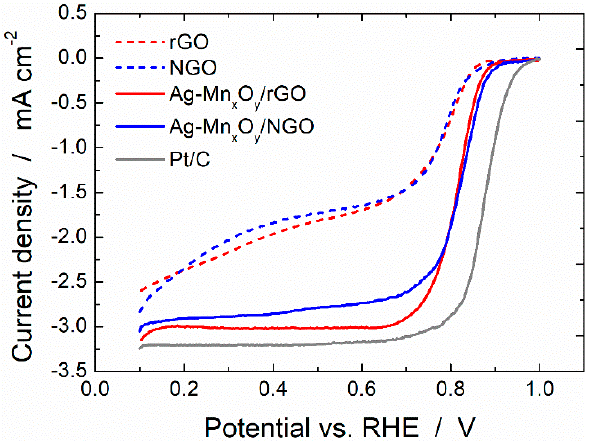
Figure 5. Potentiodynamic ORR curves of Ag-Mn x O y /rGO and Ag-Mn x O y /NGO catalysts, support materials, and comm. Pt/C in O 2 saturated 1 M KOH at 10 mV s − 1 at 1600 rpm.